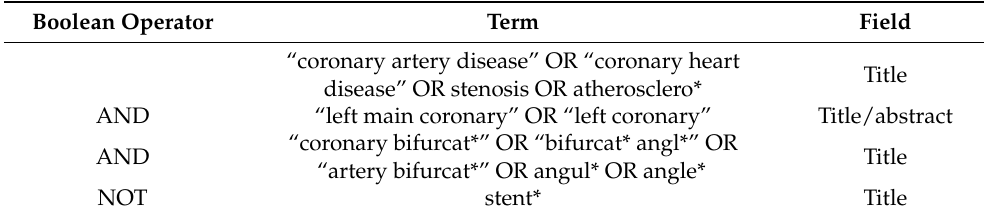
Table 1. Search strategy with use of a combination of key words. Boolean Operator Term Field “coronary artery disease” OR “coronary heart disease” OR stenosis OR atherosclero* AND “left main coronary” OR “left coronary”